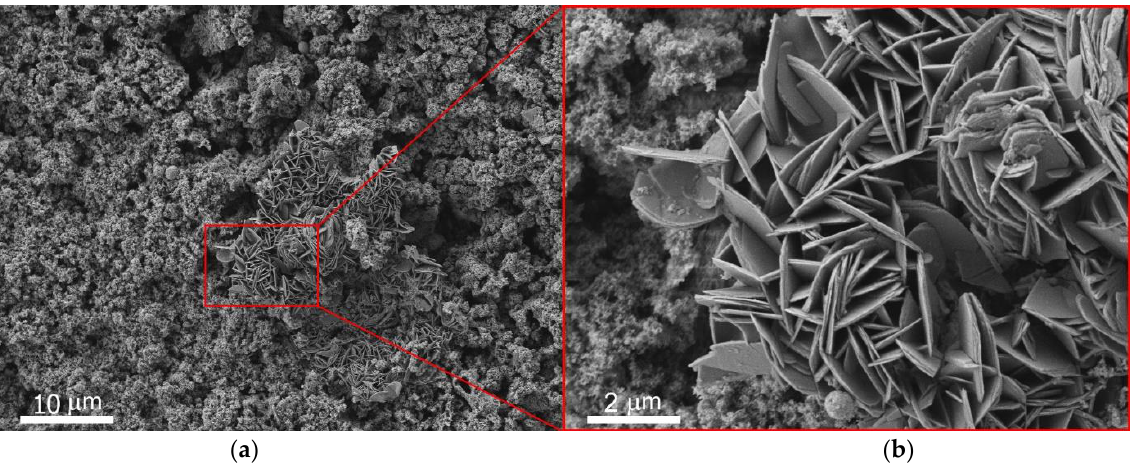
Figure 7. SEM images of the superhydrophobic surface after prolonged immersion in NaCl solution showing the formation of the magnesium hydroxide platelets: ( a ) survey image; ( b ) detailed image of the platelets.